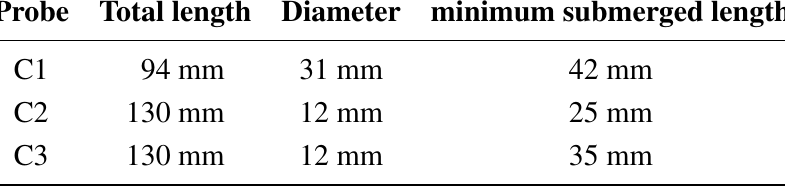
Table 1. Dimensions of tested probes. Source: own